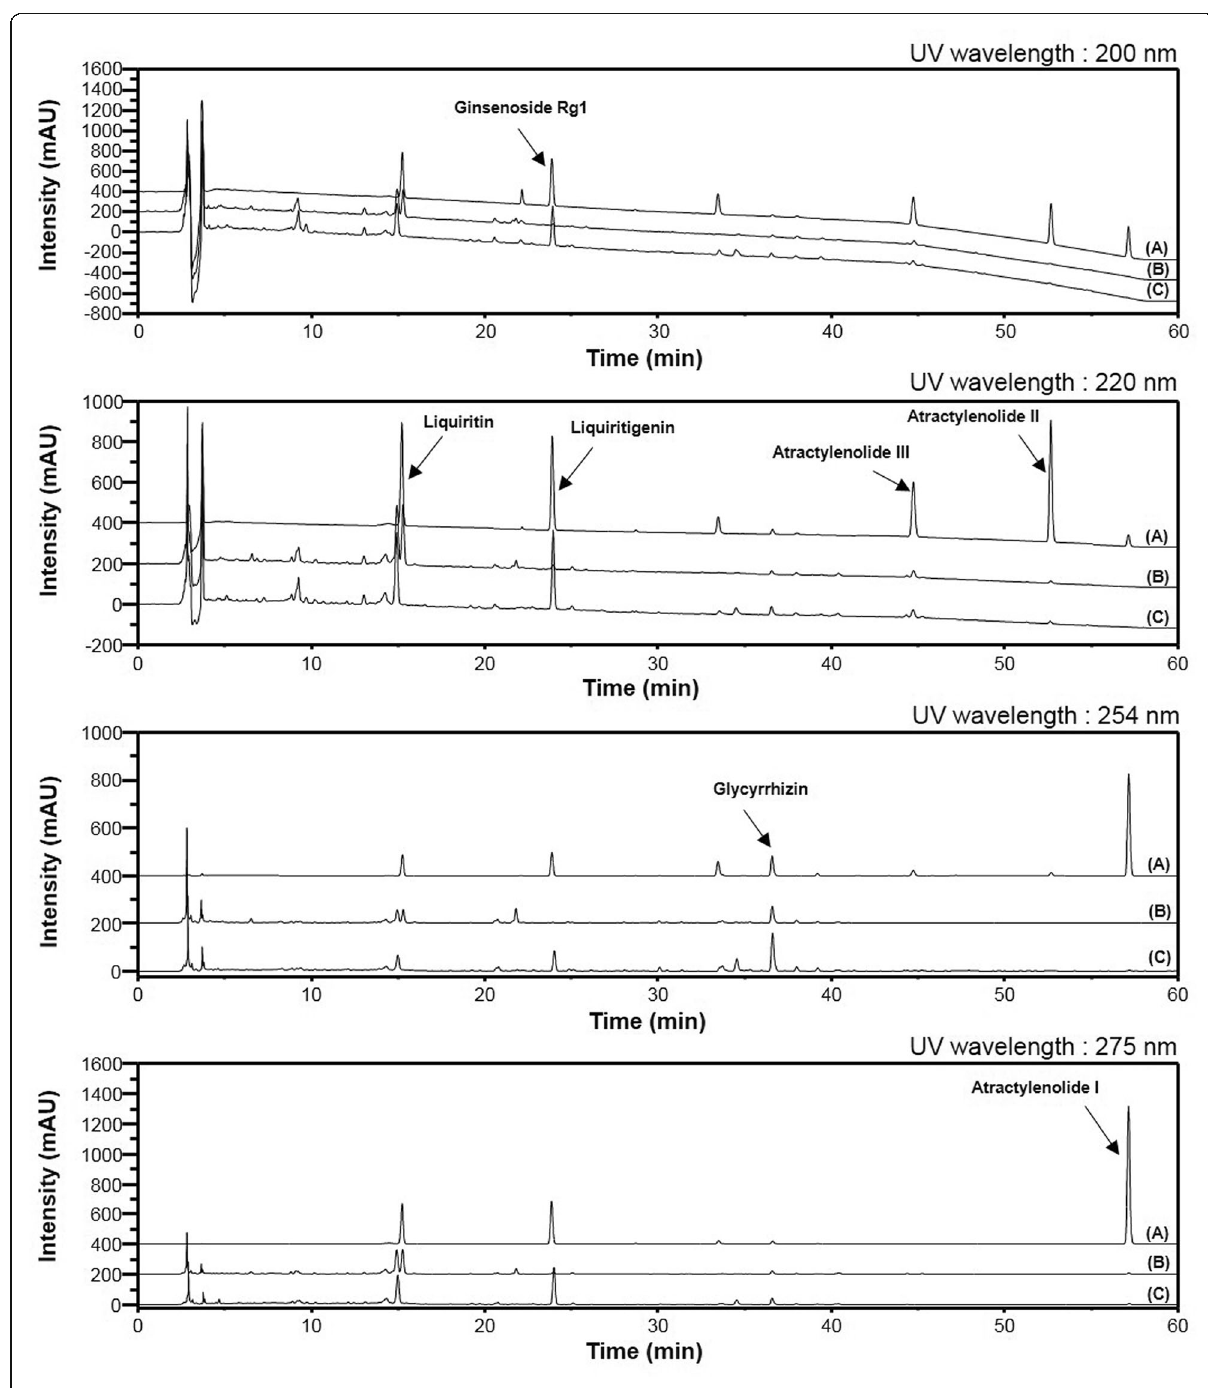
Fig. 2 HPLC-DAD chromatogram of standard mixture ( a ), SGT ( b ) and SGT166 ( c